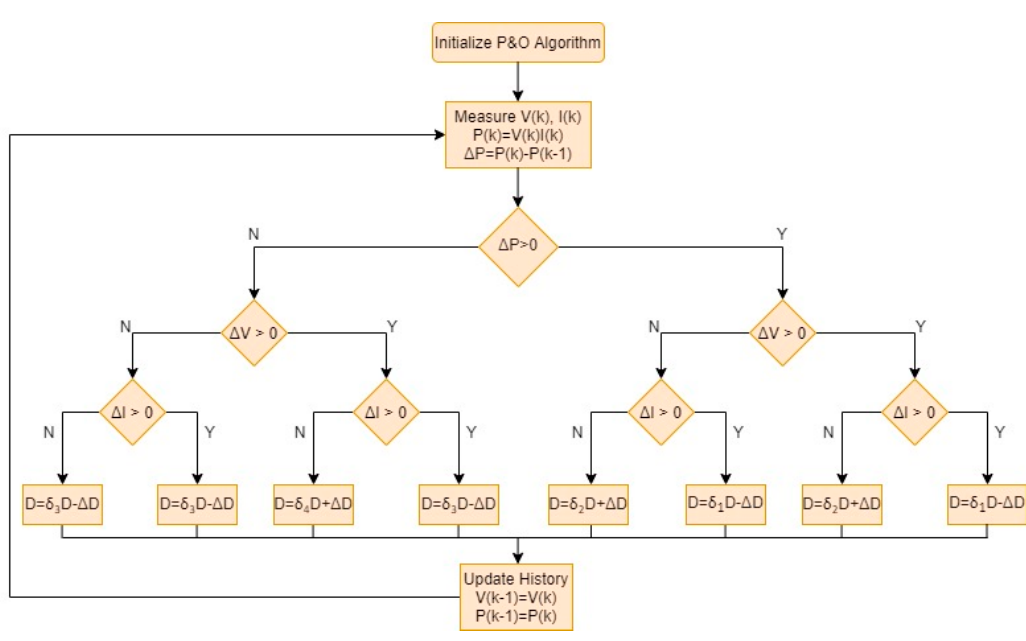
Figure 4. Flowchart of the modified P&O algorithm.